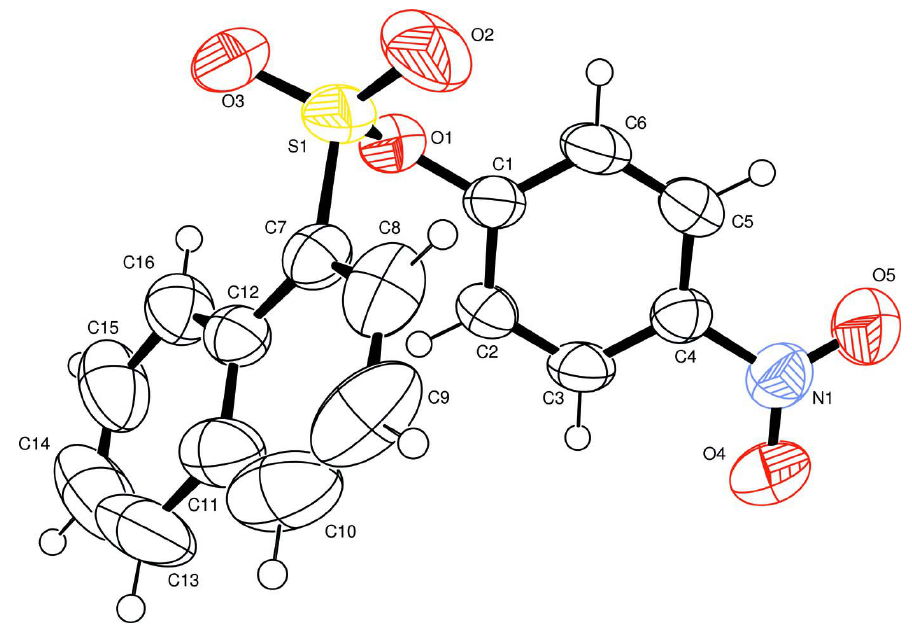
Figure 1 The molecular structure of (I), with atom labels and 50% probability displacement ellipsoids for non-H